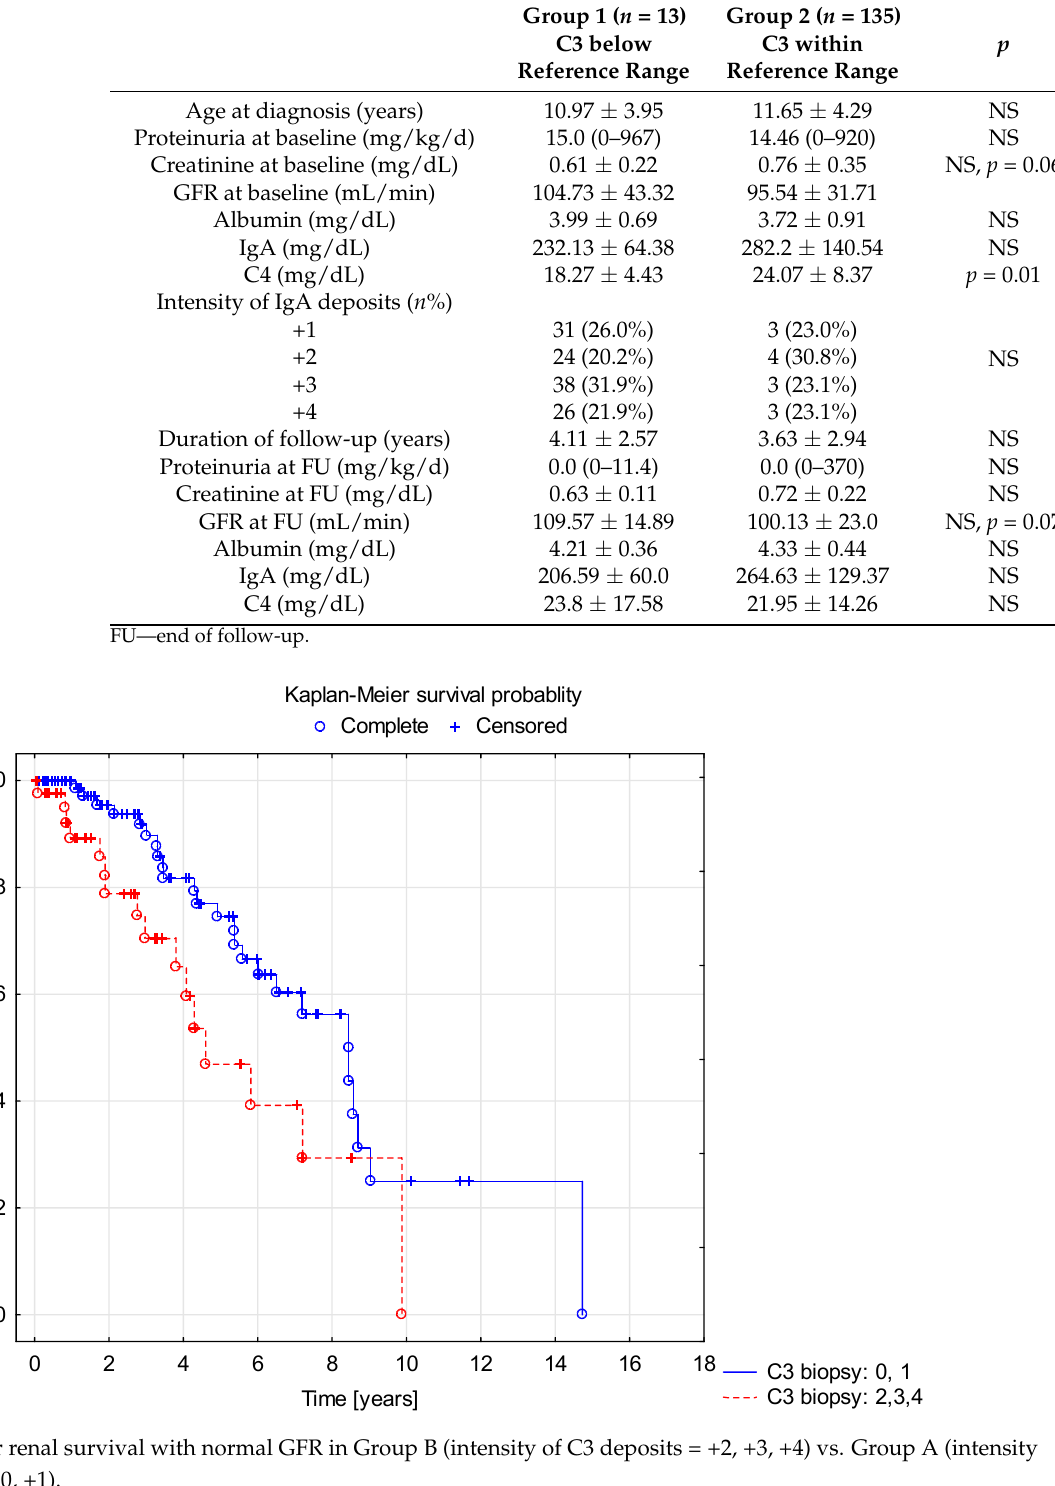
Figure 3. Shorter renal survival with normal GFR in males vs. females.